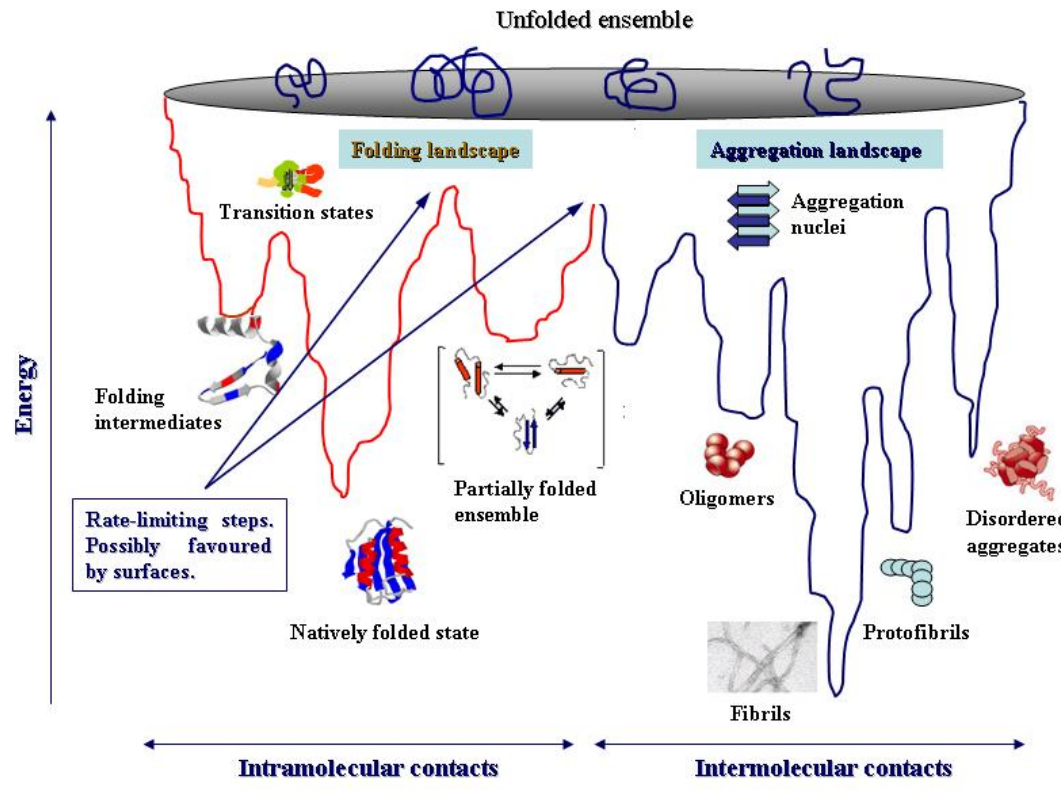
Figure 3. Combined protein folding/aggregation